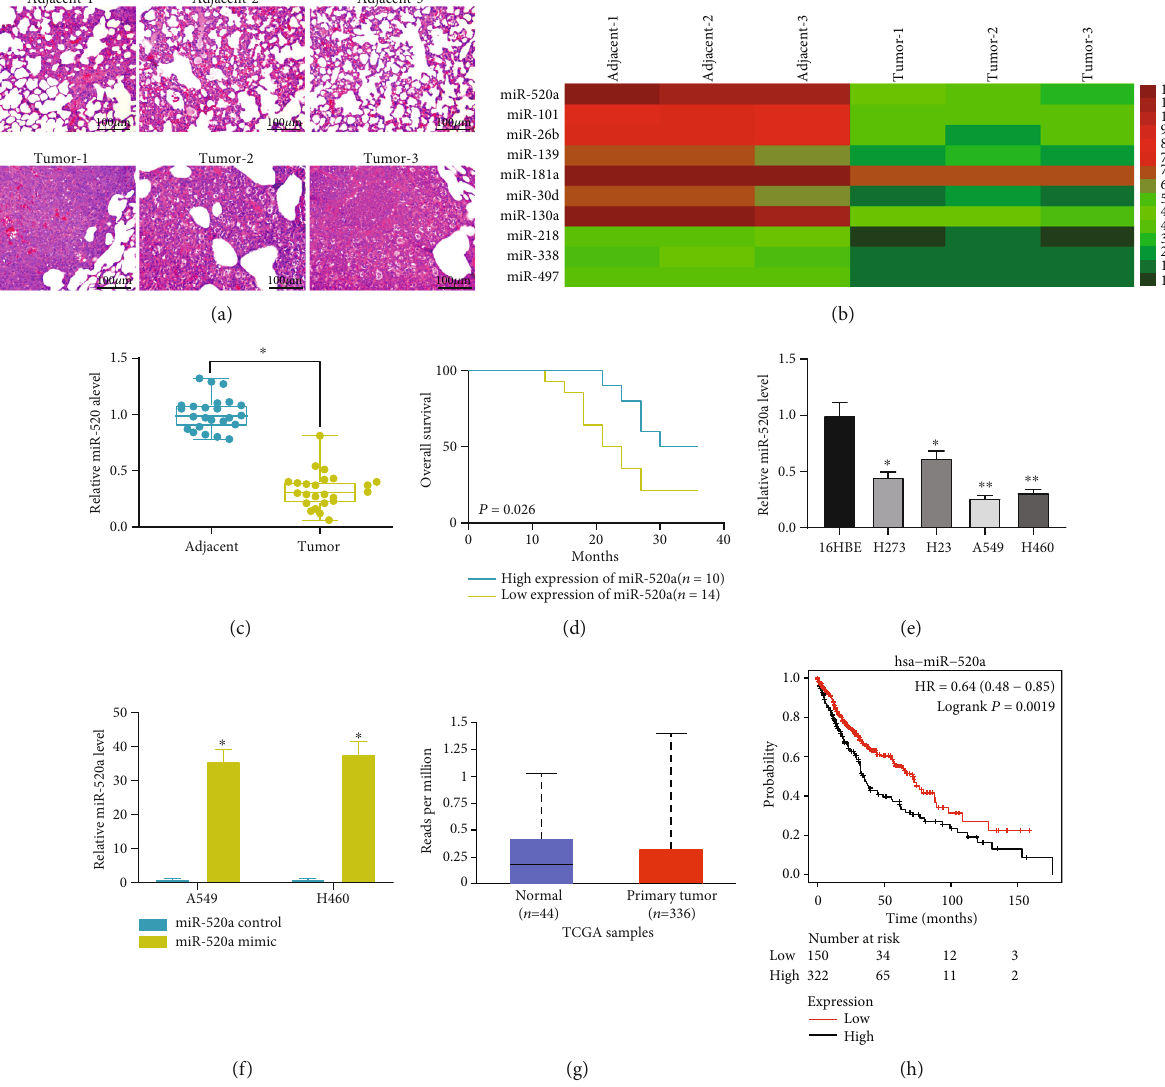
Figure 1: miR-520a is poorly expressed in NSCLC tissues and cells. (a) NSCLC tissues and the adjacent normal tissues observed by HE staining. (b) Di ff erentially expressed miRNAs between cancer and the adjacent normal tissues screened out by miRNA microarray analysis. (c) The miR-520a expression in NSCLC and the adjacent normal tissues determined by RT-qPCR ( ∗ p < 0 : 05 , two-way ANOVA). (d) Overall survival rate of patients with di ff erent levels of miR-520a according to a 3-year followed-up study. (e) The miR-520a expression in NSCLC cell lines and in normal pulmonary epithelial cell line 16HBE determined by RT-qPCR ( ∗ p < 0 : 05 , one-way ANOVA). (f) The miR-520a expression in A549 and H460 cells after miR-520a mimic/control transfection determined by RT-qPCR ( ∗ p < 0 : 05 , two-way ANOVA). (g) The expression of miR-520a in NSCLC predicted on the TCGA database. (h) Relevance of miR-520a to the survival of patients predicted on the TCGA